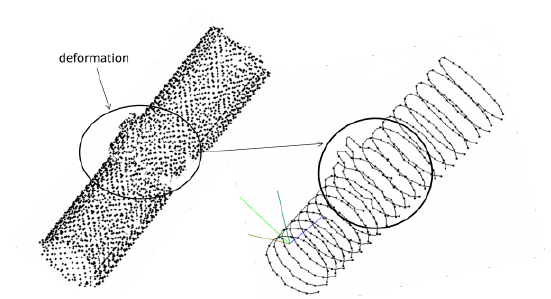
Figure 14. Modelling deformations using profiles. Variations in the curvature values at deformed points are